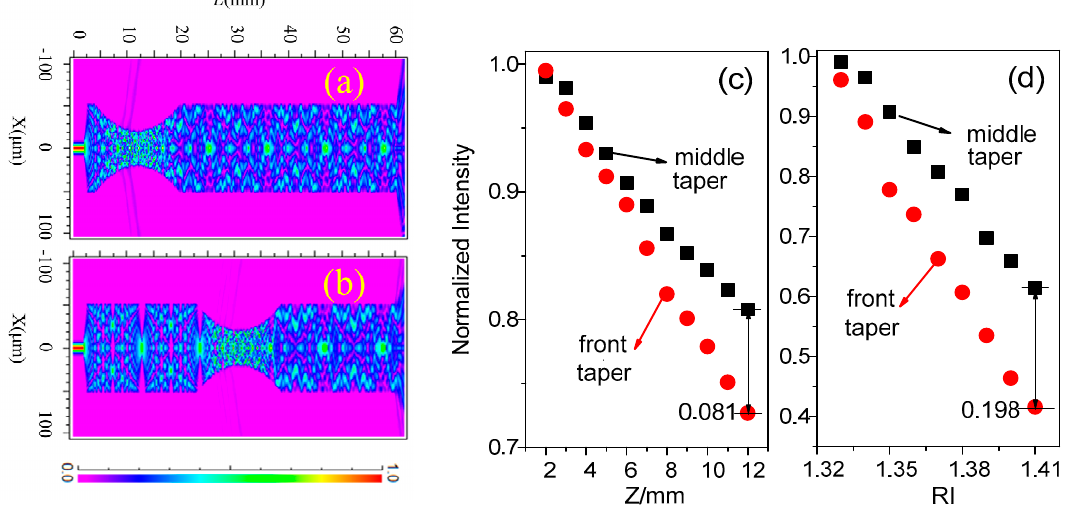
Figure 2. Interference patterns in ( a ) front and ( b ) middle tapers, and the normalized intensity of tapered fiber structures with varied ( c ) transitional area length and ( d ) external refractive index (RI).